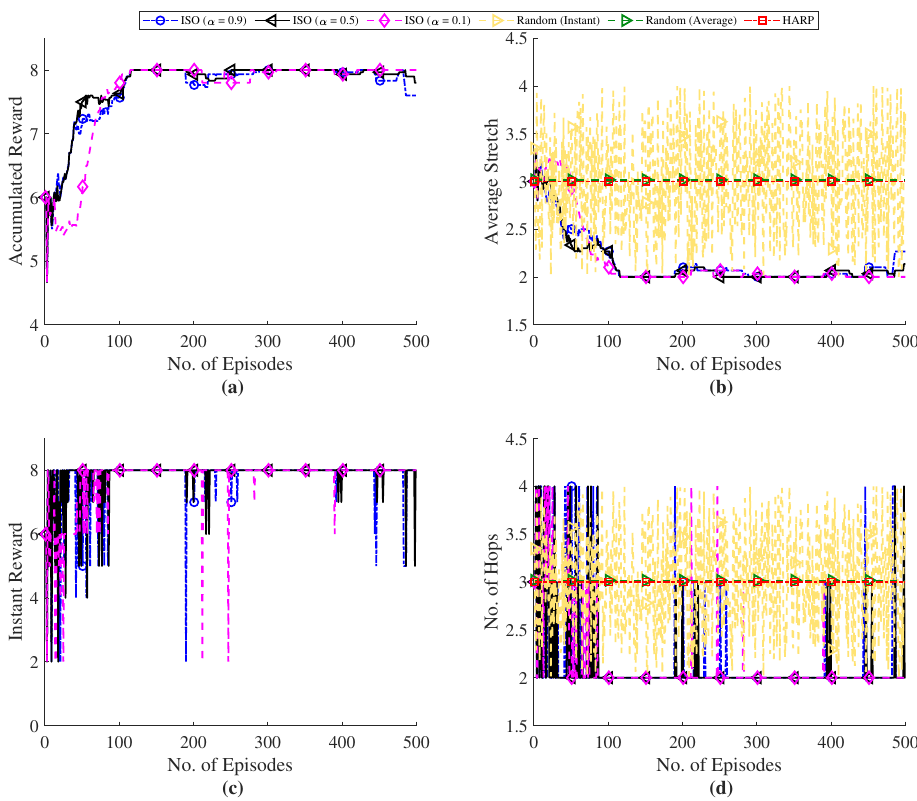
Figure 7. Stretch reduction and routing optimization progress of ISO at γ = 0.5: ( a ) Accumulated reward gain; ( b ) Average stretch gain; ( c ) Reward earned per episode; ( d ) Total hops/routers covered per